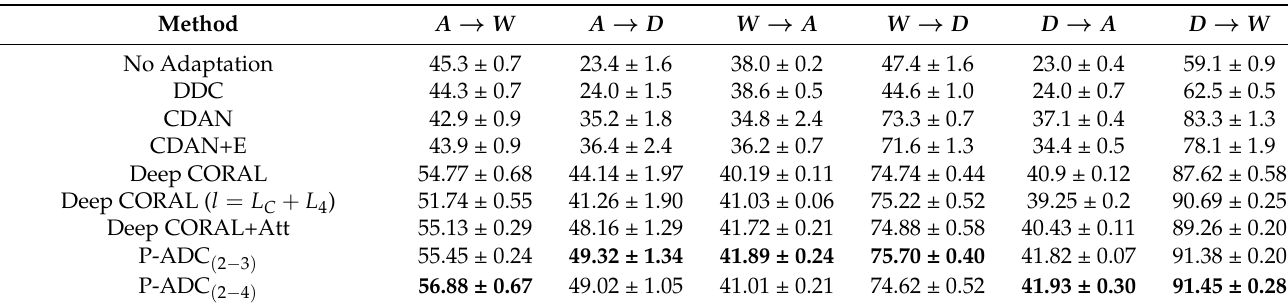
Table 1. Target accuracies for all six domain shifts in the Office-31 dataset (training epoch = 100). Note that L ( a − b ) = ∑ b ∑ t λ i l p − norm , L C = l CLASS , and P-ADC ( a − b ) = P-ADC p = a i = 1 loss function, L ( a − b ) denotes the p-norm loss function where p ranges from a to b, and a and b are natural numbers greater than 1. Bold denotes the highest accuracy.